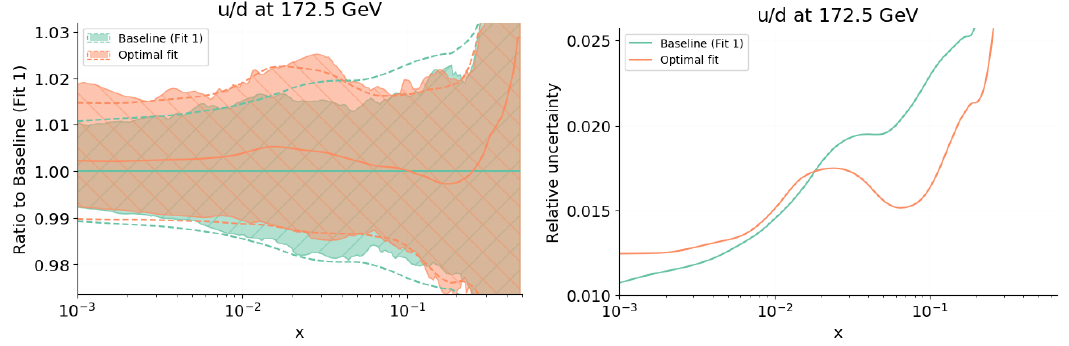
Figure 14 . Same as (cid:12)gure 11 but for the up-quark to down-quark PDF